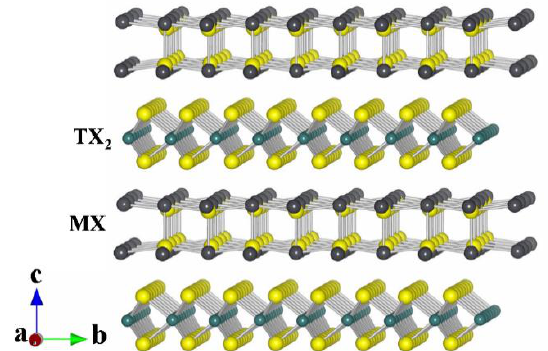
Figure 1. Schematic representation of the structure of misfit layered compounds (MLCs) (MX) 1 + y TX 2 viewed from the [100] direction. Green, gray, and yellow full circles are T, M, and X atoms, respectively. The MX layer has a (distorted) rocksalt structure while the TX 2 is a layer with hexagonal lattice.